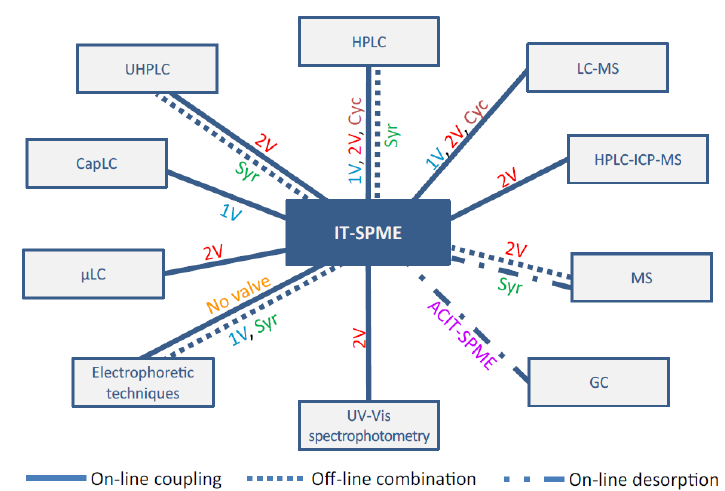
Figure 3. Schematic diagram of possible coupling and configurations of in-tube SPME with analytical instruments. Flow through mode 1V = one valve; 2V = two valves. Cyc = Draw/eject cycles mode. ACIT = array capillary in-tube. Syr = Syringe configuration. Adapted from Reference [67]. Reproduced by permission from Elsevier.